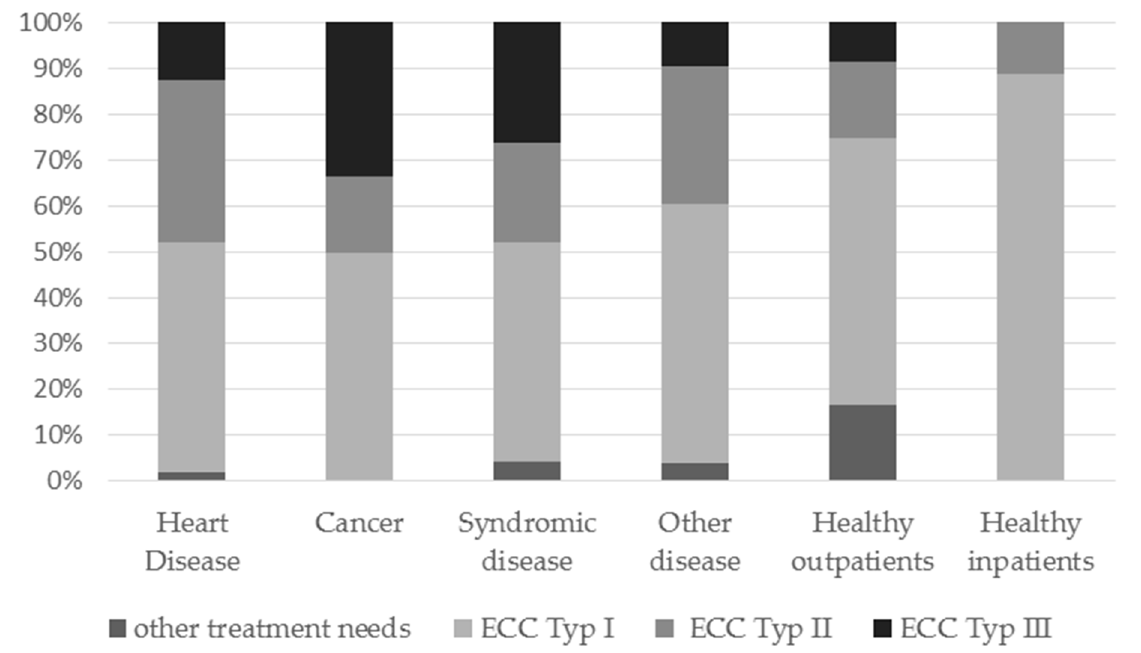
Figure 2. Distribution of ECC according to Wyne [38] regarding each group of treated children at baseline.